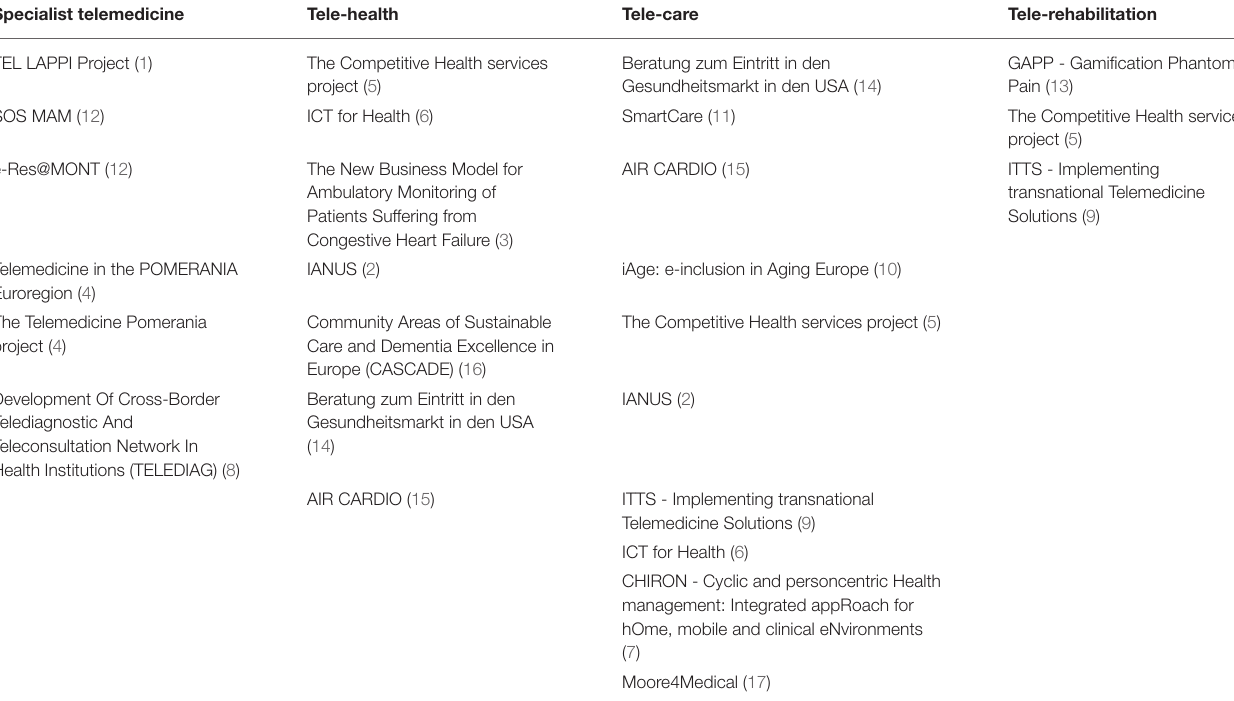
TABLE 2 | Projects